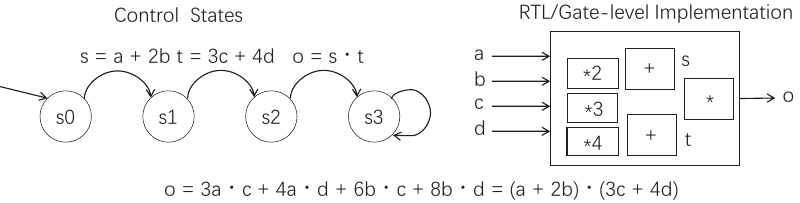
Figure 7. A possible RTL implementation in Figure 6.